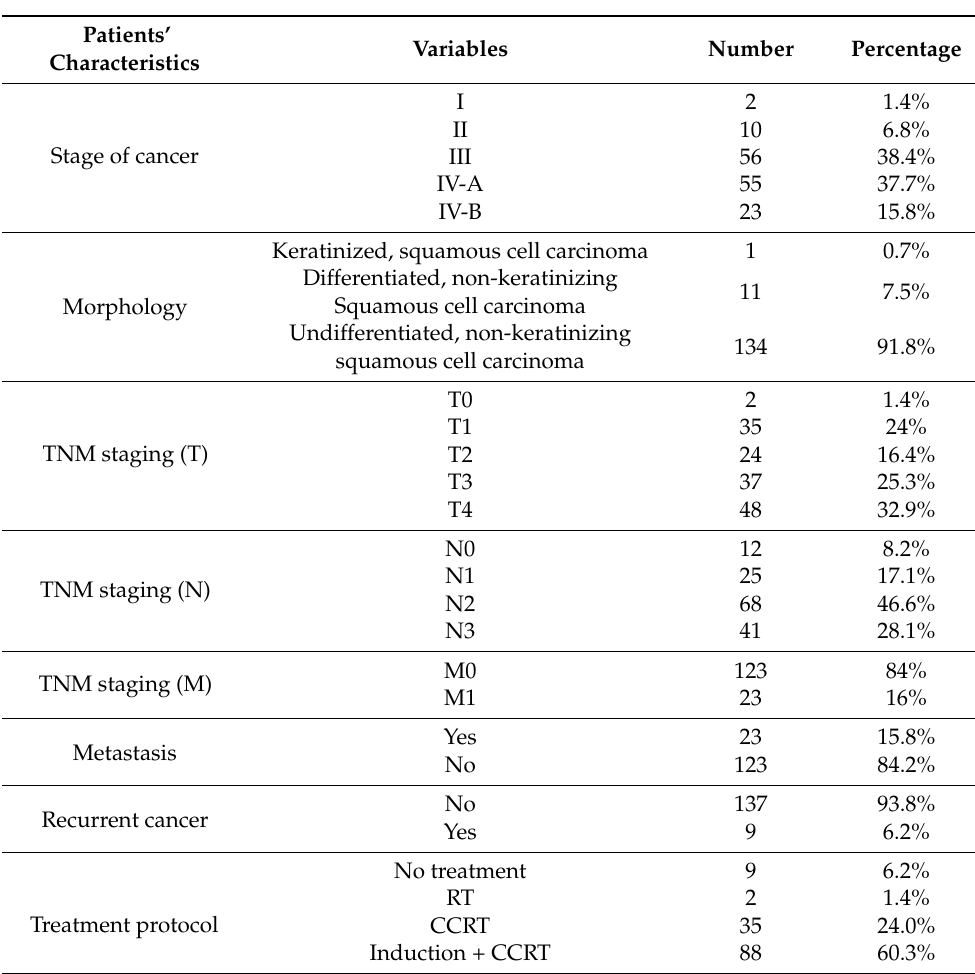
Figure 1. Histopathological examination of nasopharyngeal carcinoma observed under 20 × magni- fication. ( A ) Keratinizing squamous cell carcinoma. ( B ) Non-keratinizing differentiated squamous cell carcinoma. ( C ) Non-keratinizing undifferentiated squamous cell carcinoma. ( D ) EBER in situ hybridization stain for EBV positive. ( E ) EBER in situ hybridization stain for EBV negative. Table 2. Patients’ cancer